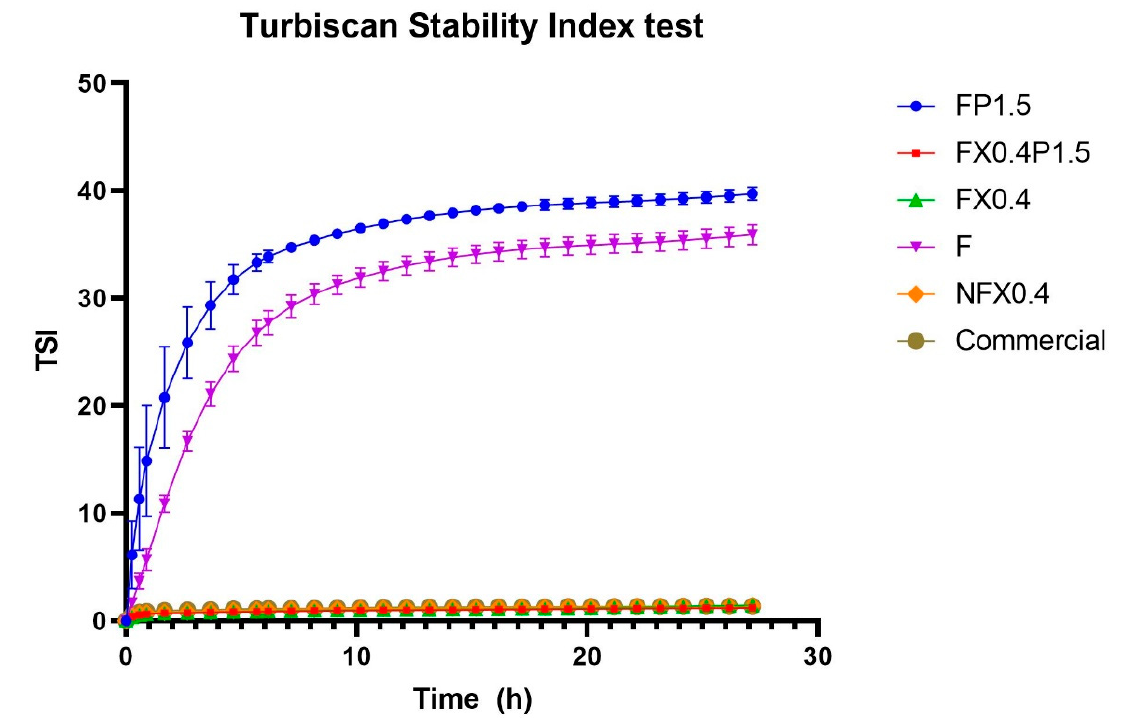
Figure 3. Turbiscan Stability Index. Measured over 27 h at 5 °C of non-fermented chufa drink with 0.4% xanthan gum (NFX0.4), fermented chufa drink with 0.4% xanthan gum (FX0.4), fermented chufa drink with 0.4% xanthan gum and 1.5% potato protein (FX0.4P1.5), fermented chufa drink with 1.5% potato protein (FP1.5), fermented, non-formulated chufa drink (F), and a commercial cold buttermilk soup. Data are presented as mean values of triplicates.